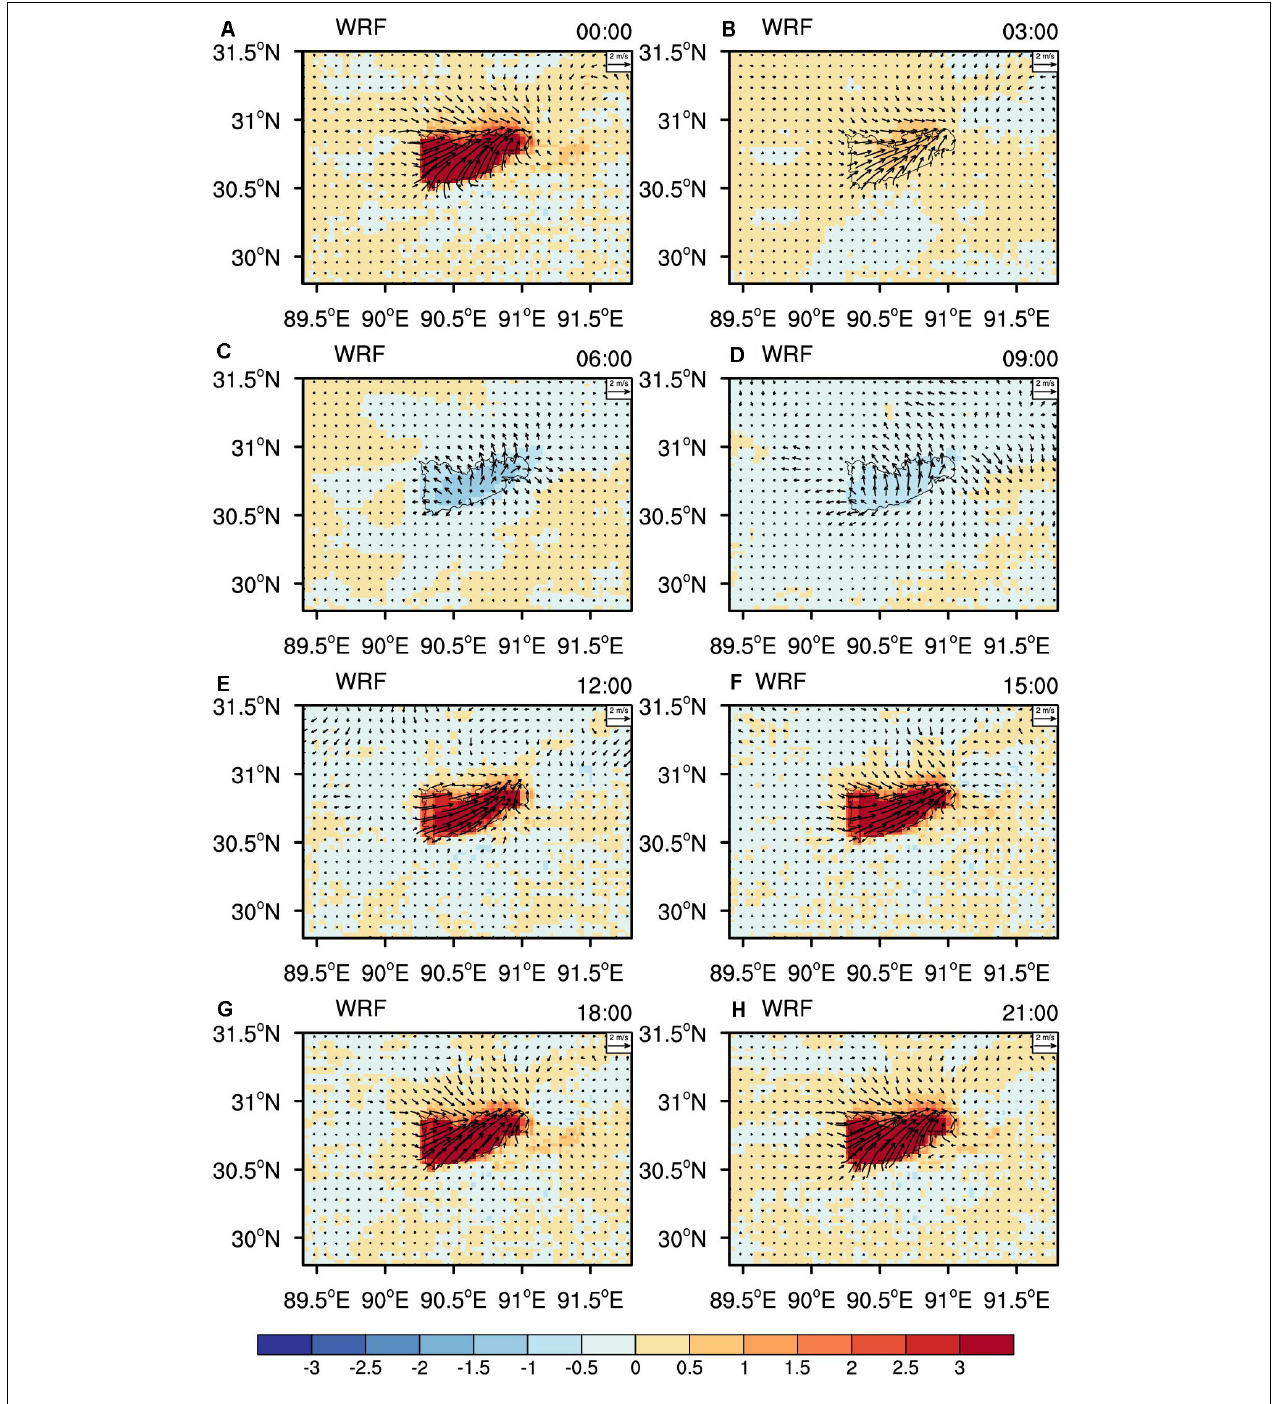
FIGURE 10 | Same as Figure 9 , but for October